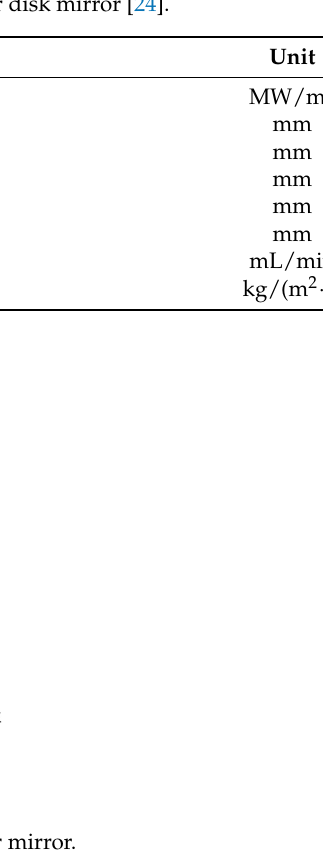
Table 7. Assumed conditions for simulation of a laser disk mirror [24].